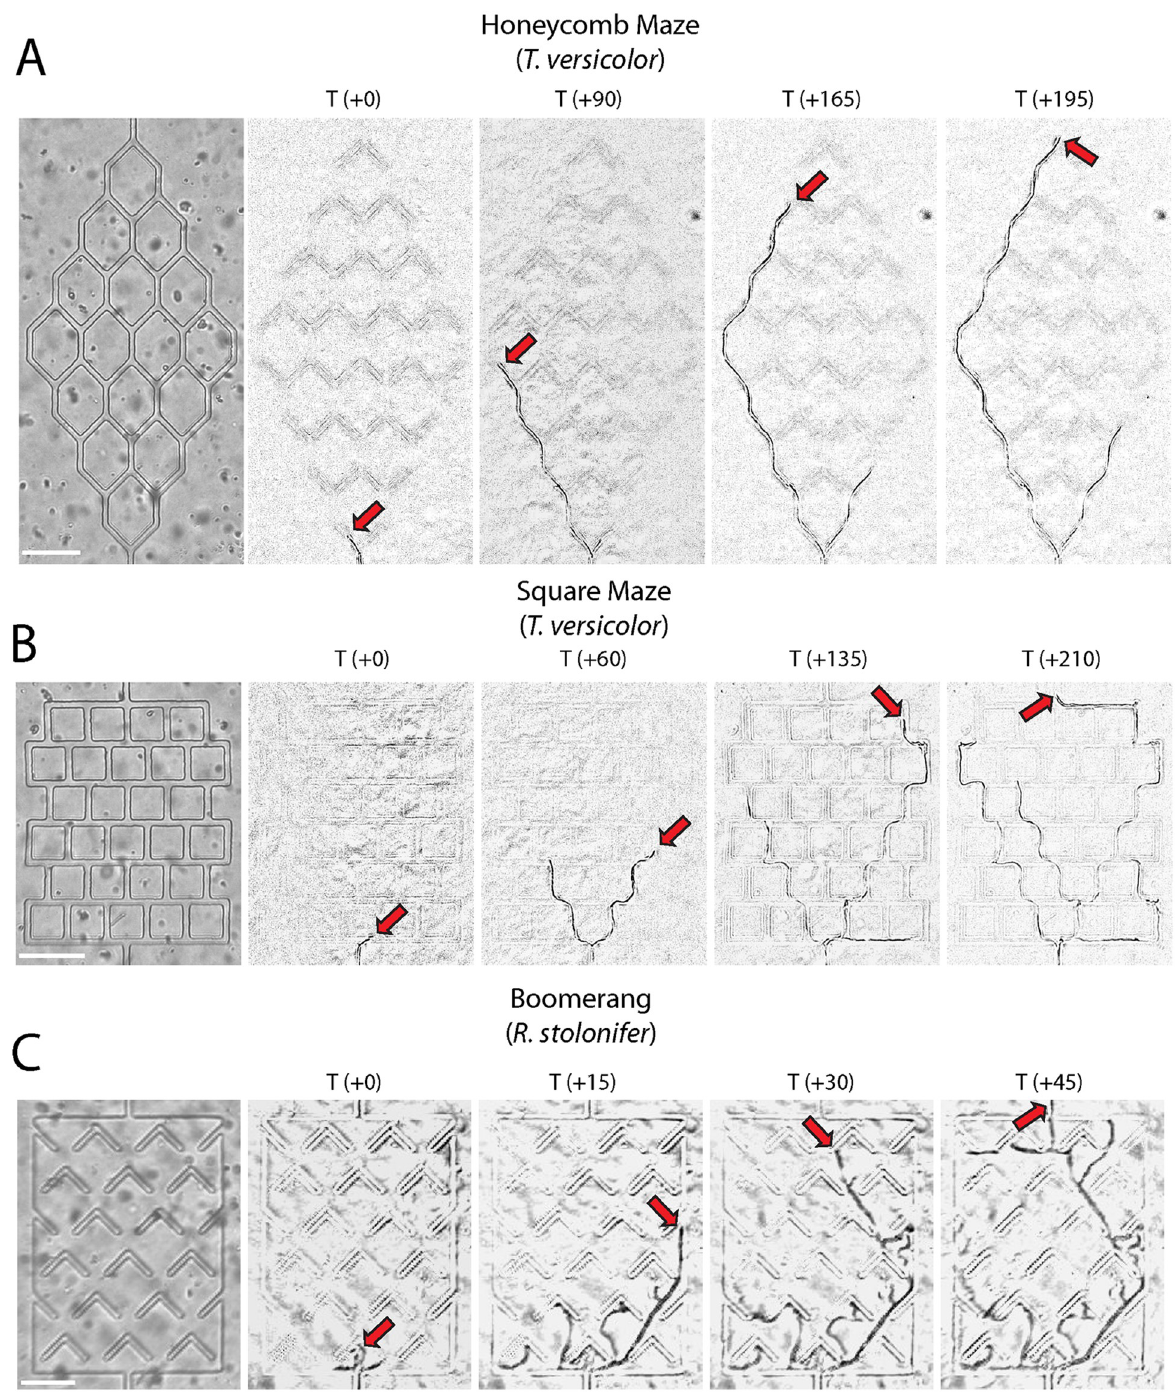
Fig 3. Fungal growth in maze obstacles. (A) Honeycomb mazes challenge the growing hyphae with channel bifurcations at acute angles. (B) Square mazes consist of orthogonal channels forcing right-angle turns for growing hyphae. (C) Boomerang obstacles are such that growing hyphae have to turn more than 90 degrees to avoid being trapped. Red arrows indicate the leading hyphal tip. (T) is time, in minutes, from the point the hypha enters the channel. Scale bars are 100 μ m.